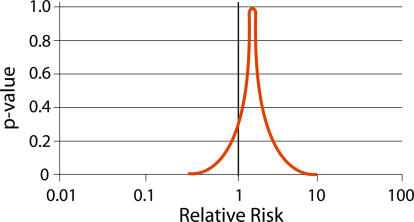
Author's Graph of
p-Value Function Based on Data in [
30]
(Illustration: Sapna Khandwala)